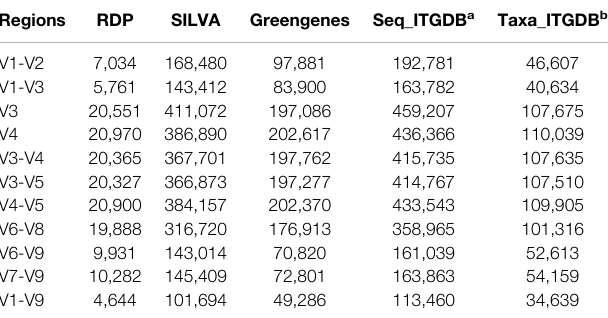
TABLE 1 | The sequence number of the hypervariable regions in the source databases and ITGDB.